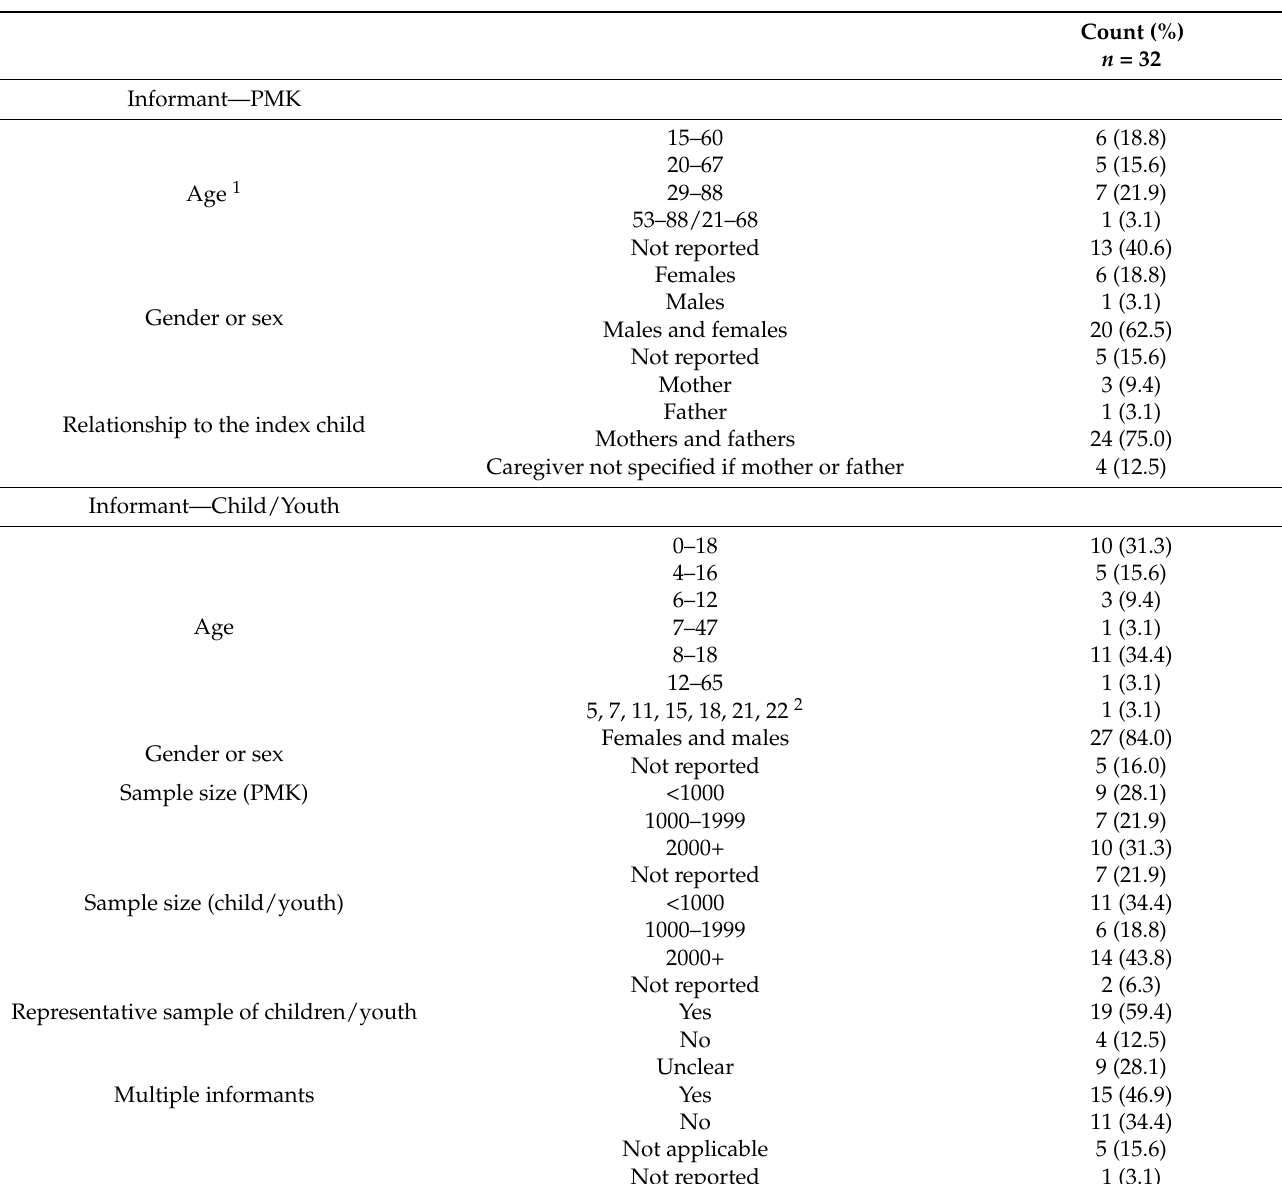
Table 3. Sample characteristics of included